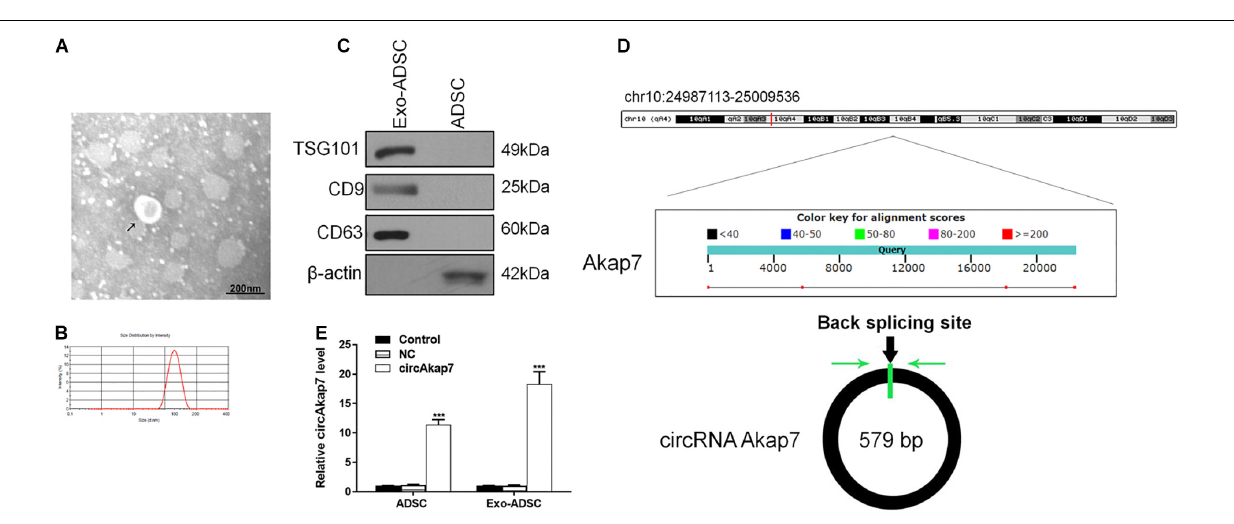
(mmu_circ_0000154, mm9_circ_010383) is derived from